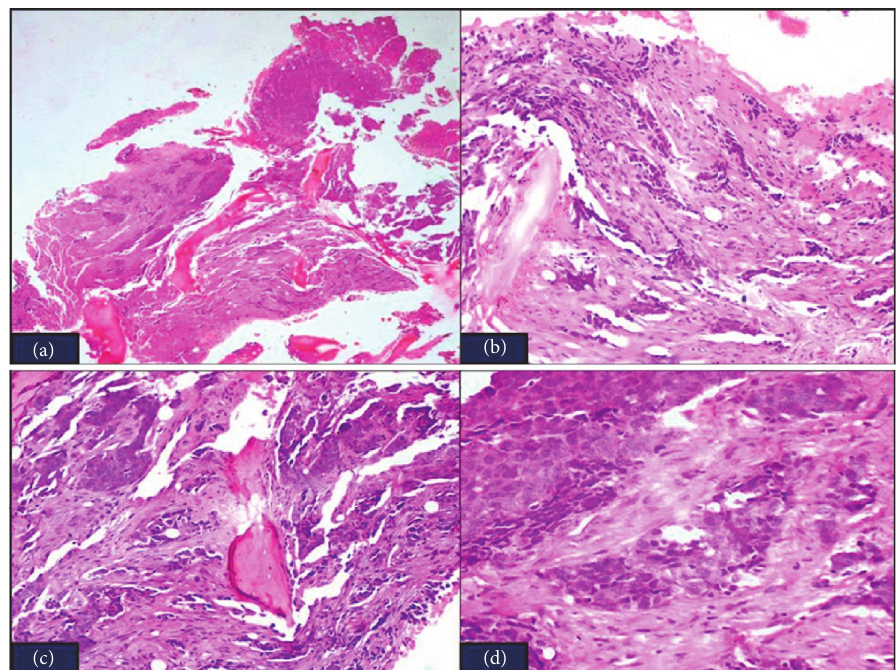
Figure 1: (a) Bone marrow biopsy (H&E × 4). (b) Cords and sheets of malignant tumor cells with surrounding desmoplastic reaction (H&E × 100). (c) Tumor cells intermingled with normal haematopoietic cells of the bone marrow (H&E × 200). (d) Poorly differentiated tumor cells (H&E × 400).